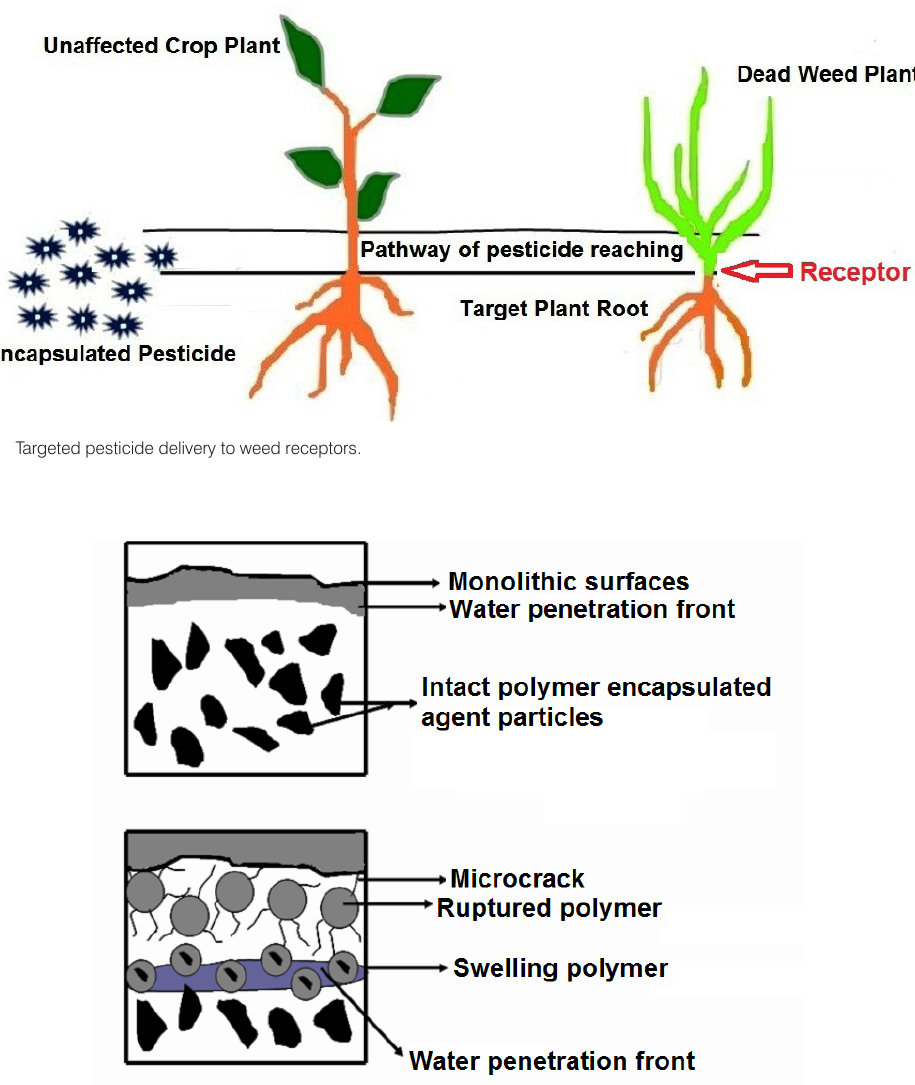
Figure 5. Encapsulated agent release from biopolymer matrix at water penetration